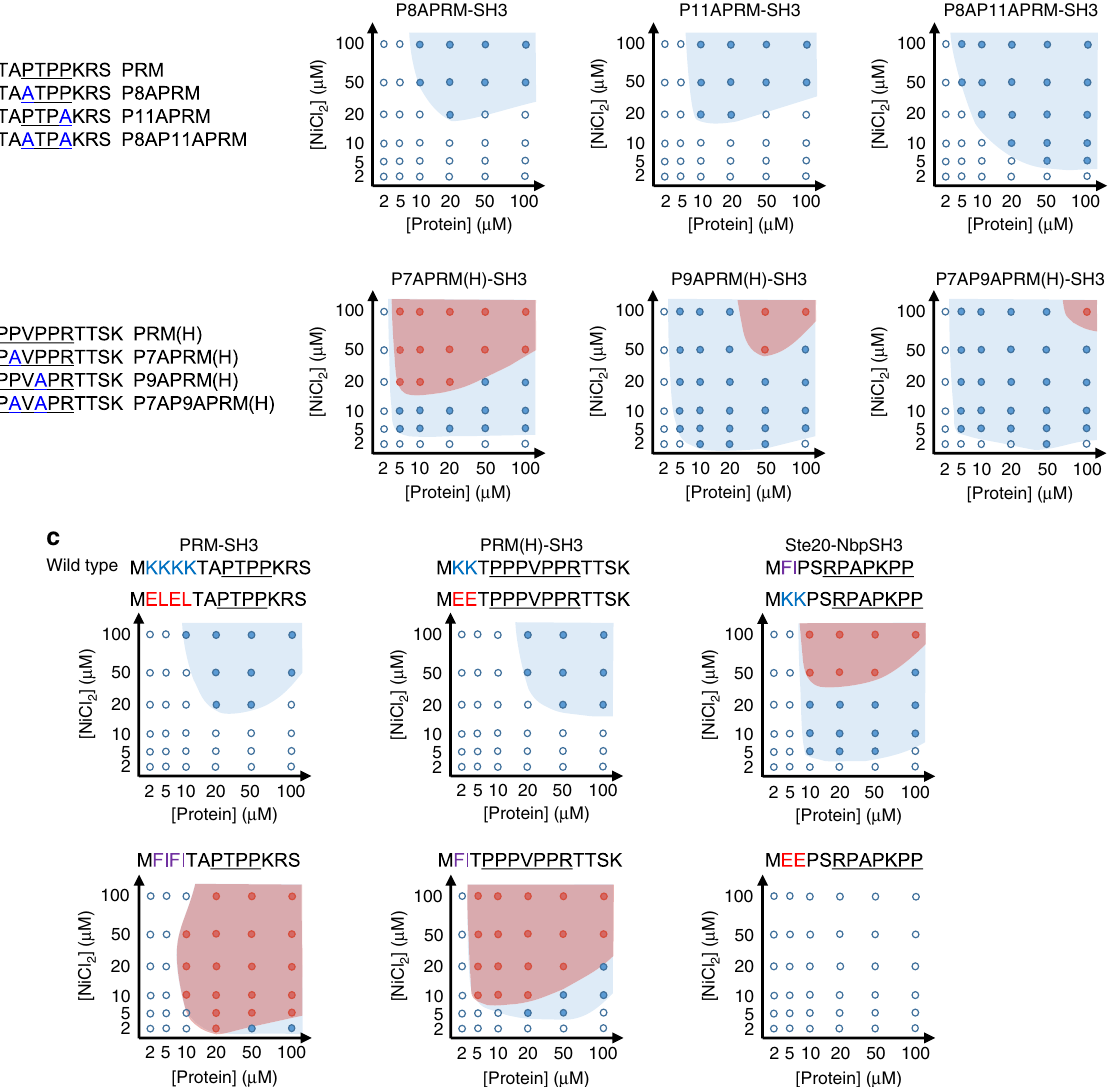
Fig. 4 Phase separation alternation by modi fi cations of ligand – receptor binding interfaces. a Phase diagrams of PRM-SH3-6His with Pro-to-Ala mutations. Mutated PRM sequences are shown in the left. b Phase diagrams of PRM(H)-SH3-6His with Pro-to-Ala mutations. Mutated PRM(H) sequences are shown in the left. c Phase diagrams of ligand-SH3-6His with charge and hydrophobic mutations. Mutated ligand sequences with wild-type sequences are shown in the top of diagrams. Pro-rich core consensus-binding motifs are